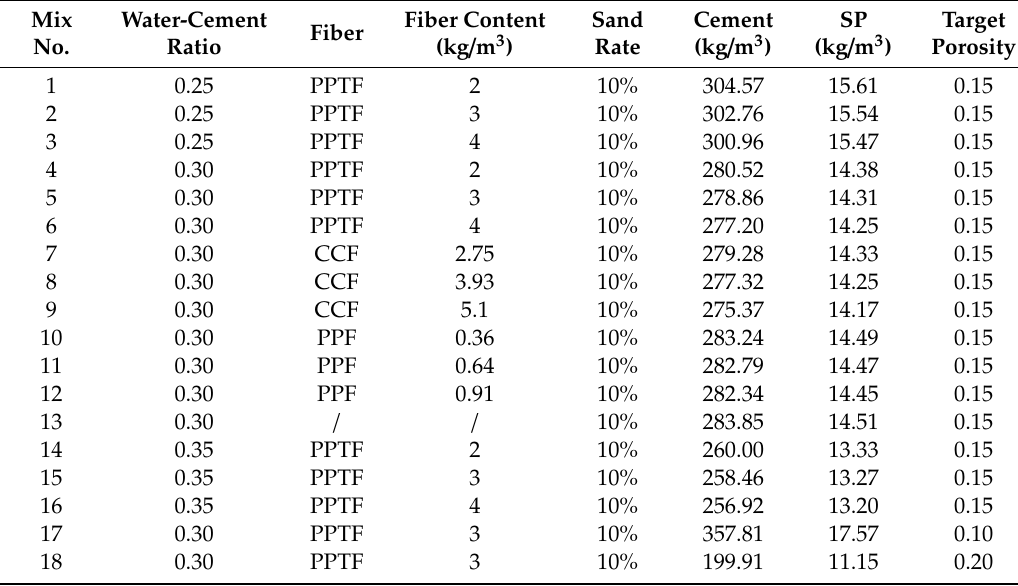
Figure 3. Schematic of permeability coefficient test set up.